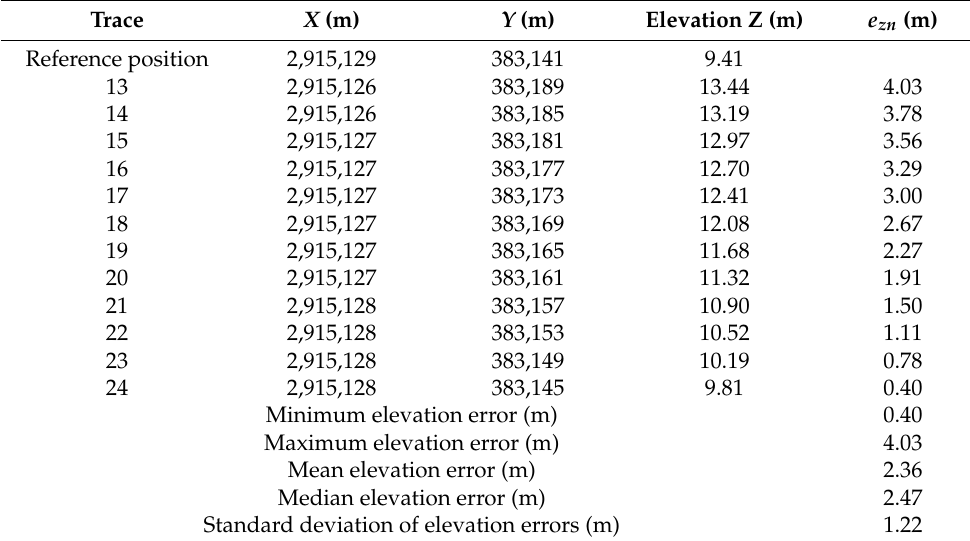
Table 4. Elevation values and errors of the 12 studied traces. Errors are measured with respect to the datum elevation at 9.41 m giving a relative mean and standard deviation of about 25% and 13%,